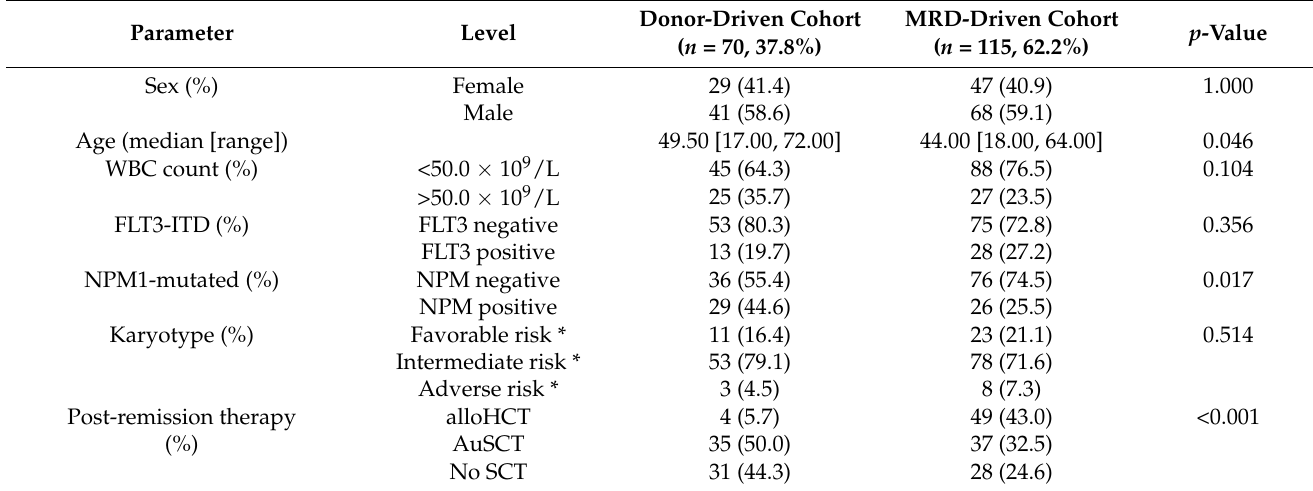
Table 1. Clinical characteristics of patients belonging to MRD-driven and donor-driven